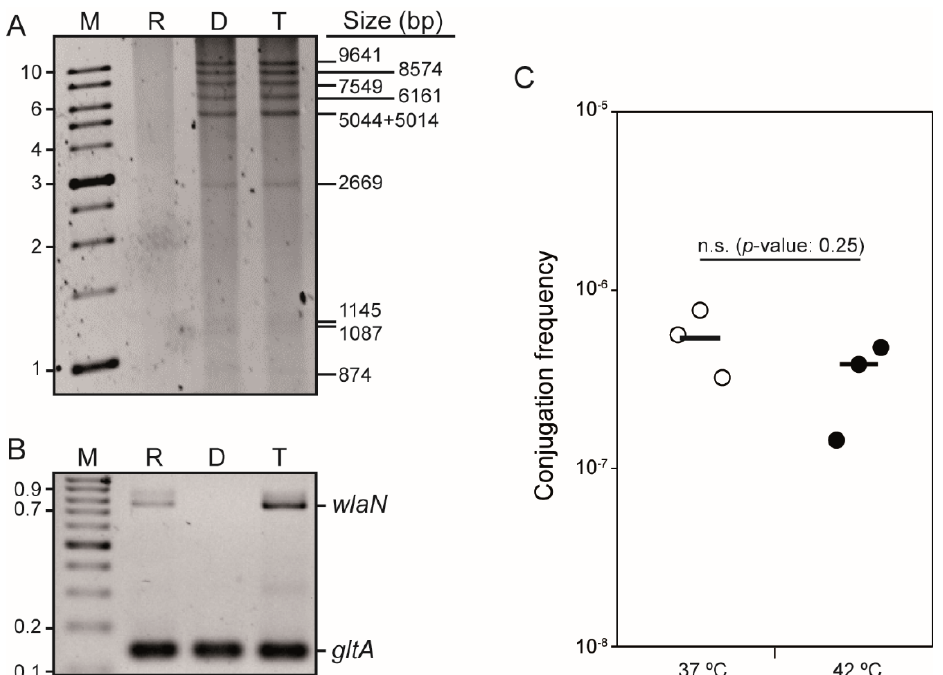
Figure 2. The pCjH01 plasmid from the H01 isolate is a conjugative plasmid that carries resistance to tetracycline, kanamycin, and gentamycin. ( A ) Bgl II restriction profile of DNA plasmid from recipient (R), donor (D), and transconjugant (T) strains. The R strain was A3S, and the D strain was H01. Lane M, molecular mass marker (1 Kb DNA Ladder, Nippon Genetics, Düren, Germany)—the size of some of the bands in kilobases is indicated on the left side of the panel. On the right side of the panel, the theoretical size in base pairs of the bands derived from the deduced Bgl II restriction map from the pCjH01 sequence obtained is indicated. The three lowest mass bands were better detected when the gel was overexposed (Supplementary Figure S1). ( B ) Genotyping of the R, D, and T strains, as in A, by the PCR amplification of the wlaN gene. Lane M, molecular mass marker (GeneRuler 100 bp DNA Ladder, ThermoScientific, Waltham, MA, USA)—the size of some of the bands in kilobases is indicated on the left side of the panel. PCR detection of the housekeeping gene gltA was used as a control. ( C ) Conjugation frequency of pCjH01 at 37 and 42 °C using donor and recipient cells as in A. Both cultures and mating mixtures were incubated at the indicated temperatures. Significance was tested by an impaired two-tailed t -test. Statistical significance ( p -value) is indicated, n.s. indicates no significance.